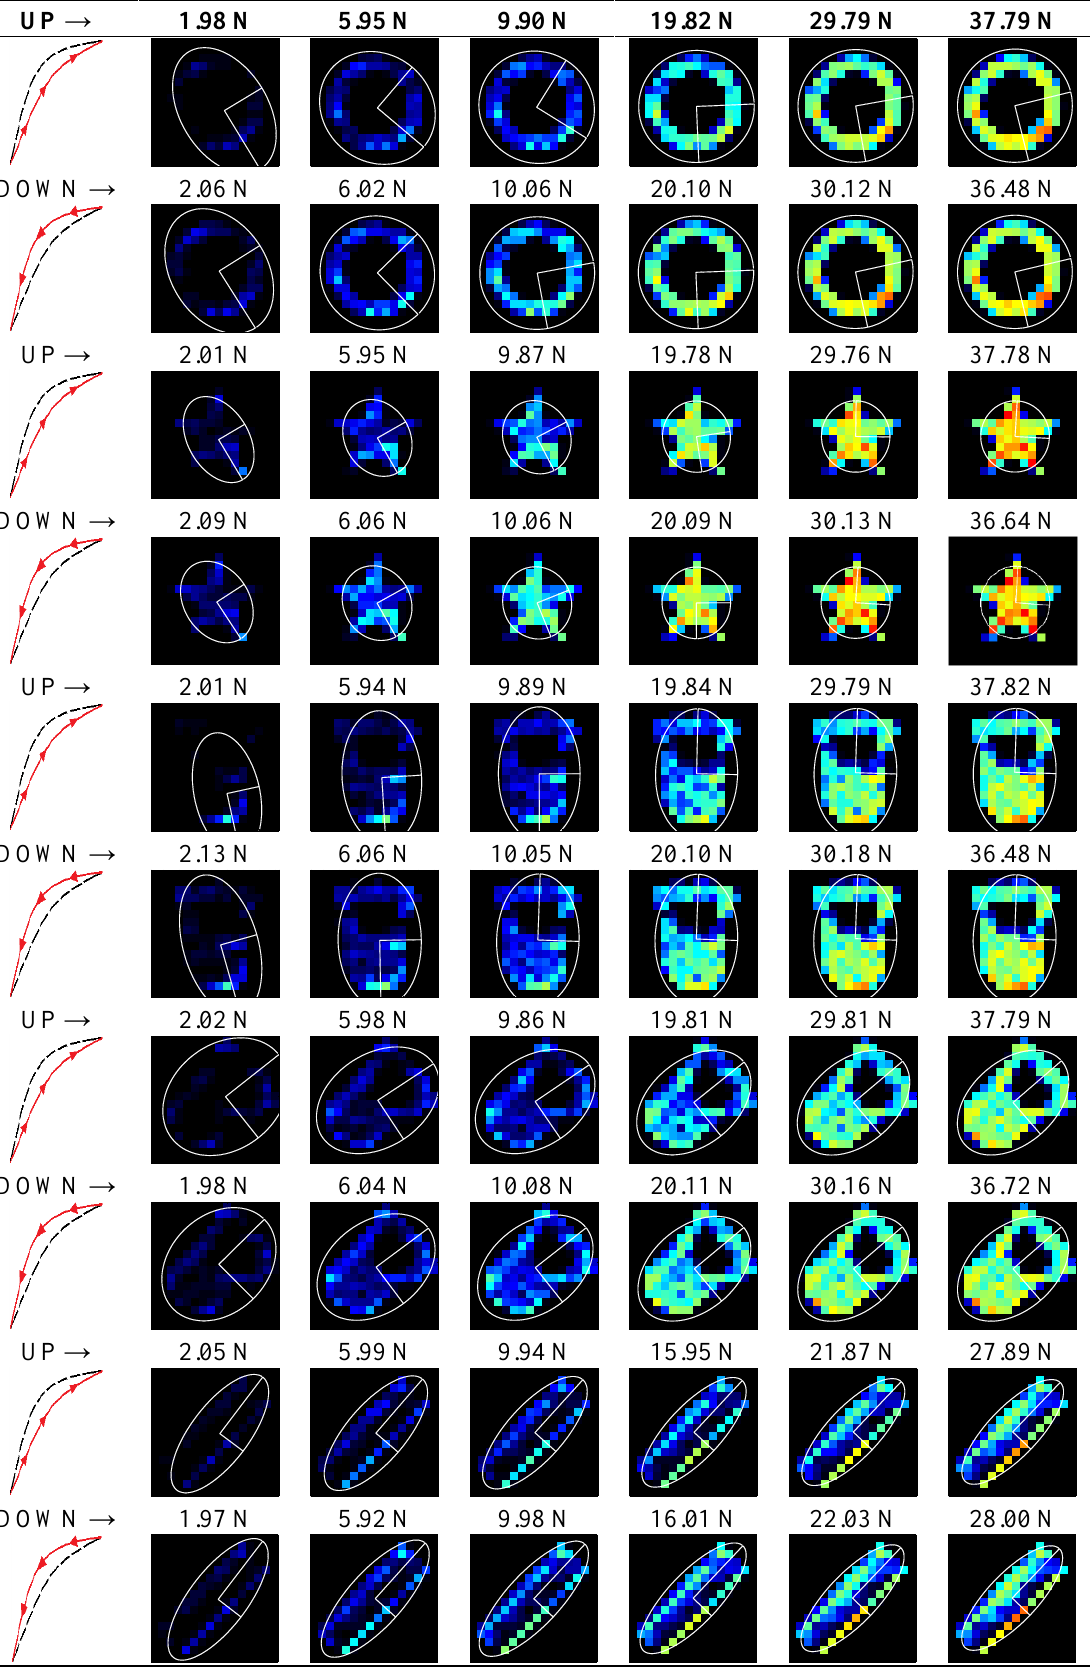
Table 5. Tactile images and ellipse for the hysteretic cycle with the objects “ring”, “star”, “opener” and “bar” on the PCB based